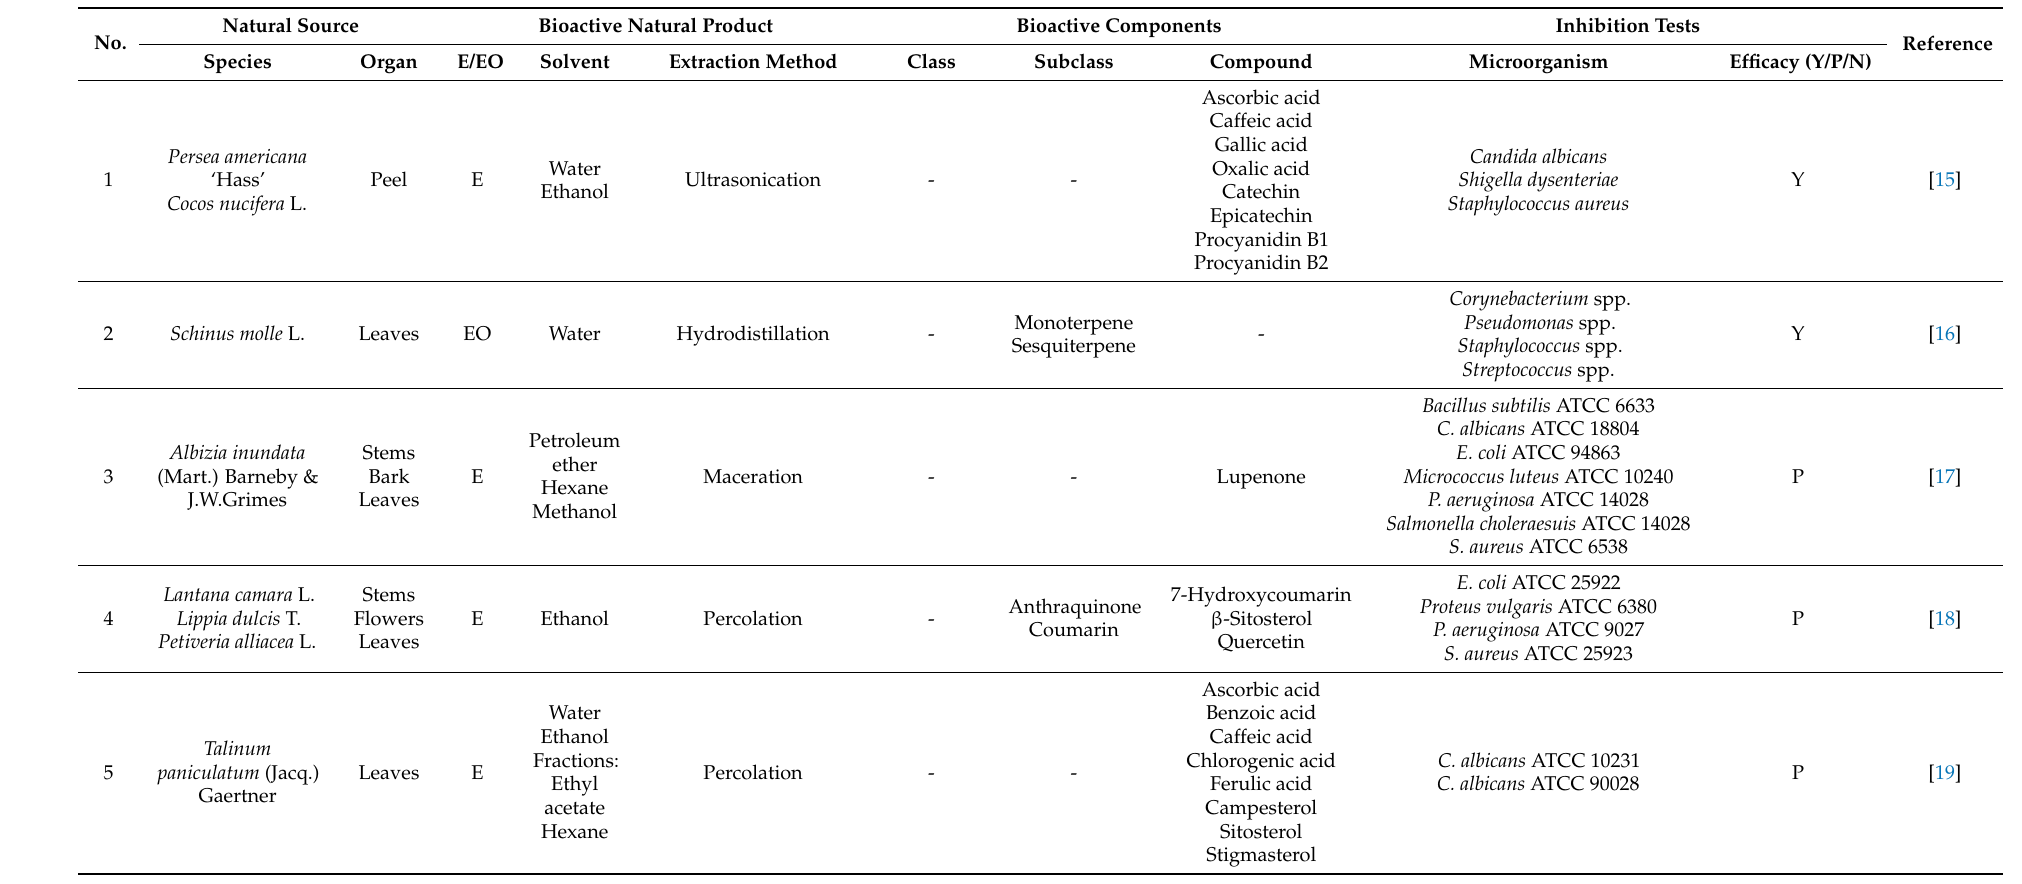
Table 2. Information extracted from relevant articles on bioactive natural products for microbial